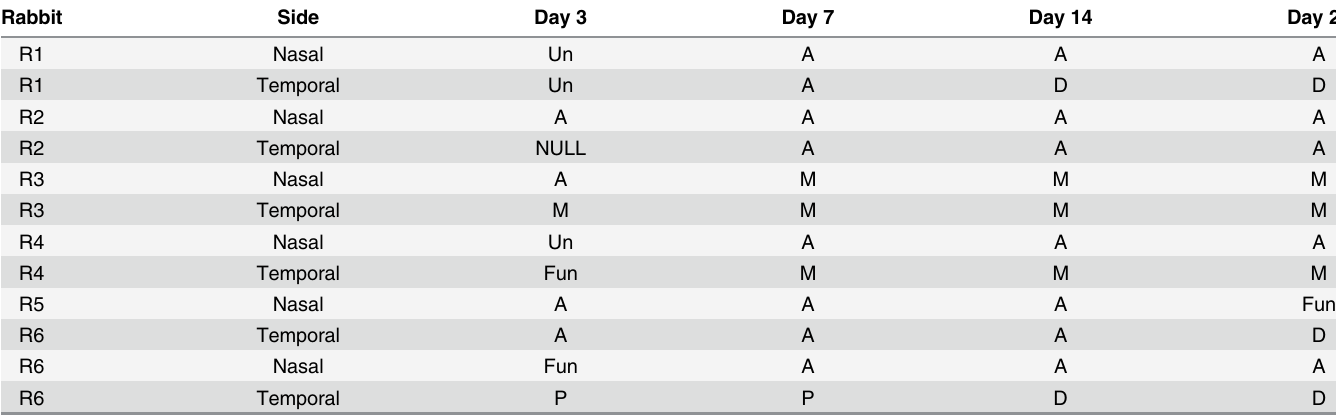
Table 1. Different capsular bend types of six rabbits at two sides (nasal and temporal) postoperatively. Rabbit